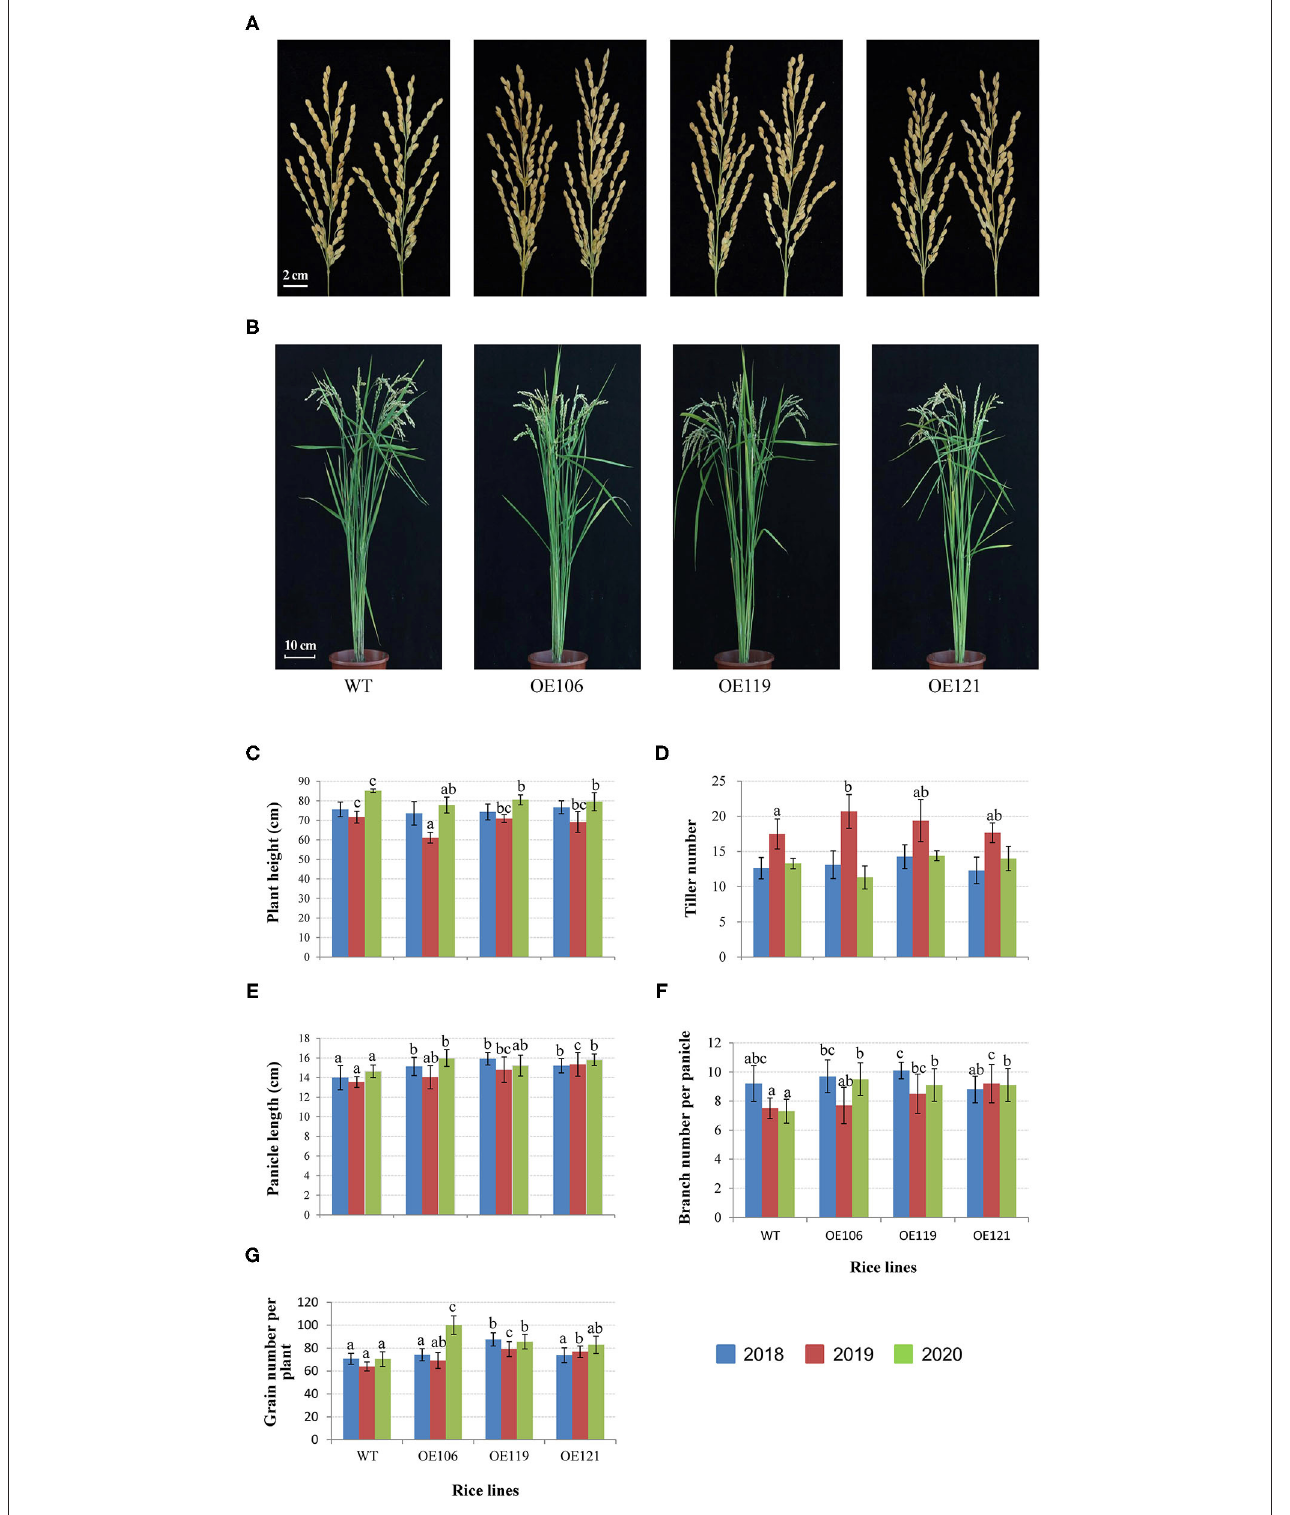
FIGURE 8 | Comparisons of agronomic traits between TaWRKY51 transgenic lines and the WT control. The images of rice panicles (A) and mature plants (B) . Comparisons of plant height (C) , tiller number (D) , panicle length (E) , panicle branch number (F) , and grain number per plant (G) . The images of rice panicles and plants were photographed in 2019. The agronomic traits were measured at the experimental station of ICS-CAAS during 2018–2020.